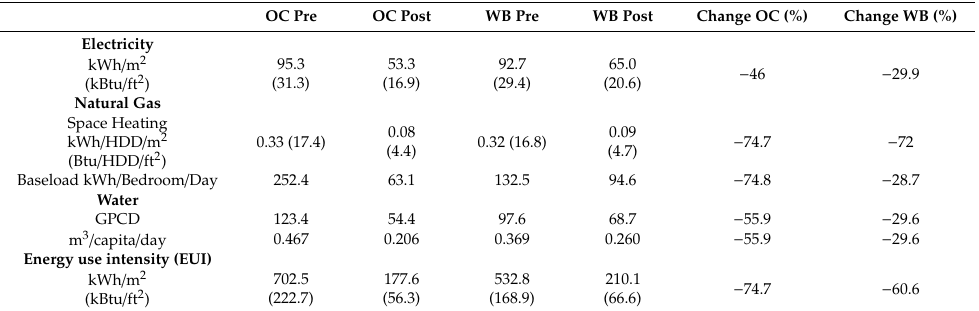
Table 2. Old Colony (OC) and Washington-Beech (WB). Pre- and post-redevelopment utility consumption and energy use intensity (EUI) and change (%) Water consumptions was measured as gallons per capita per day